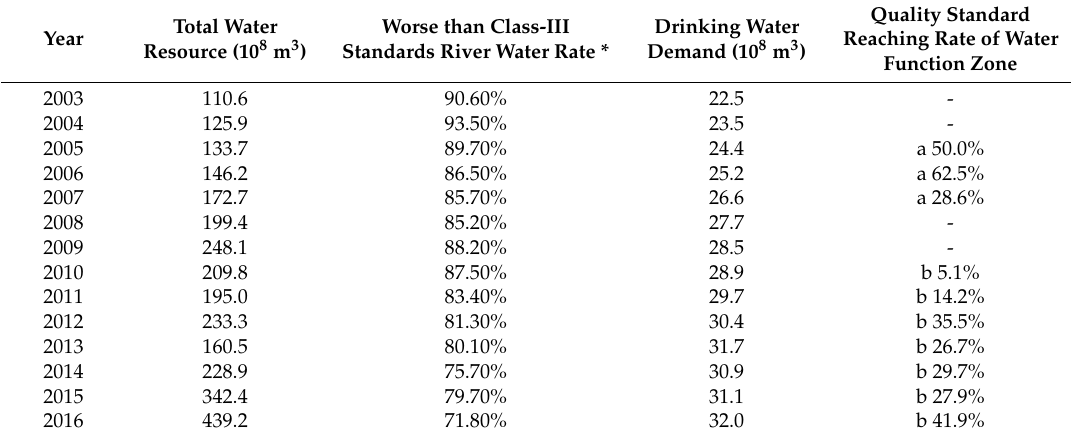
Table 2. Water resource and demand in Taihu Lake